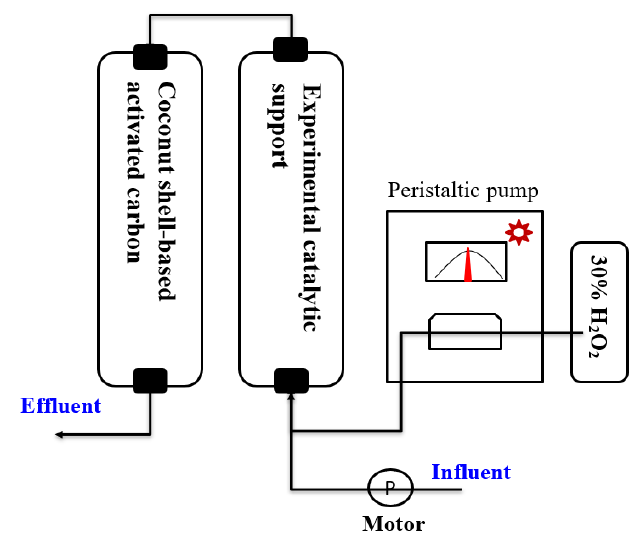
Figure 2. Schematic diagram of the laboratory pipe string test module.